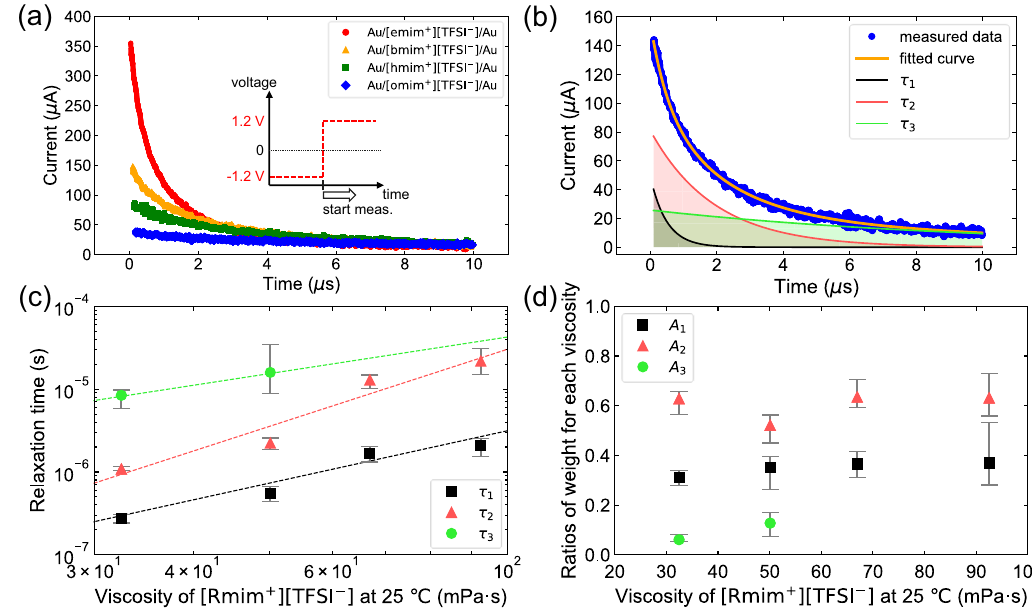
Figure 4. ( a ) Transient current responses measured with Au/[Rmim + ][TFSI − ]/Au as a function of alkyl chain length of cations in [Rmim + ][TFSI − ]. The inset indicates timing of current measurement during duration of voltage pulse. ( b ) Transient current response for Au/[bmim + ][TFSI − ]/Au with fitted curve simulated based on Eq. (1). Three types of Debye-type relaxations that constitute the fitted curve are shown by solid lines with shades. ( c ) Relaxation times as a function of the viscosity of [Rmim + ][TFSI − ]. Dashed lines represent results of fitting based on least-square method considering Eq. (2). ( d ) Ratios of weight for each viscosity as a function of viscosity of [Rmim + ][TFSI − ]. Plots for ( c ) and ( d ) indicate the average of 7 different devices and each error bar shows their minimum and maximum on the number of applied pulses because of the slower relaxation of the transient response derived from the high viscosity. For example, the normalized I out corresponding to “1110” was much higher than that corresponding to “0001” for hmim_device and omim_device. Further, the normalized I out values shown in the inset of Fig. 3 were rearranged in ascending order, to compare the dependence of normalized I out on the pattern of 4-bit pulses for each Rmim_divice, as shown in Supplementary Fig. S6 online. The normalized I out shows mostly linear depend- ency on the pattern of 4-bit pulses over all 16 patterns for bmim_device, hmim_device, and omim_device. In other words, the normalized I out increases almost uniformly with changing the pattern of 4-bit pulses from “0000” through “1000,” “0100,” …, “0111,” to “1111.” In contrast, the one for emim_device was mainly divided into two regions depending on whether the 4th applied pulses were “0” or “1;” therefore, the margins to discern I out were substantially restricted to approximately 40%. The pattern dependence of normalized I out for emim_device has the smallest slope among all the emim_device—omim_device, except for the steep slope between 4-bit pulse patterns of “1110” and “0001.” Based on the above results, it is suggested that the proposed reservoir device, Au/[Rmim + ] [TFSI − ]/Au, enables the transformation of the 4-bit time-series data into the 16 classifiable data by utilizing the transient dynamics brought about by the dielectric relaxation at the electrode–IL interface. The results of data transformation are determined by the relation between the input signal’s timescale and the relaxation time which can be tuned by controlling the viscosity of [Rmim + ][TFSI − ] as a function of the alkyl chain length of the cations. Relation between relaxation time of dielectric relaxation and viscosity of [Rmim + ][TFSI − ]. Fig- ure 4a shows the transient current responses of emim_device—omim_device which were measured under a bias voltage of 1.2 V for 10 µs. To ensure a measurable current, a bias voltage of − 1.2 V was applied until the meas- urement started at 1.2 V, as shown in the inset of Fig. 4a. The current decay became modest with an increase in the alkyl chain length of cations in [Rmim + ][TFSI − ], as well as the current decays observed in Supplementary Fig. S3a–d online. To extract the relaxation times ( τ i s), we fitted the transient current responses based on least- square method considering Eq. (1) which has a weighted sum of exponentials expressing a superposition of Debye-type relaxations 37,38 .